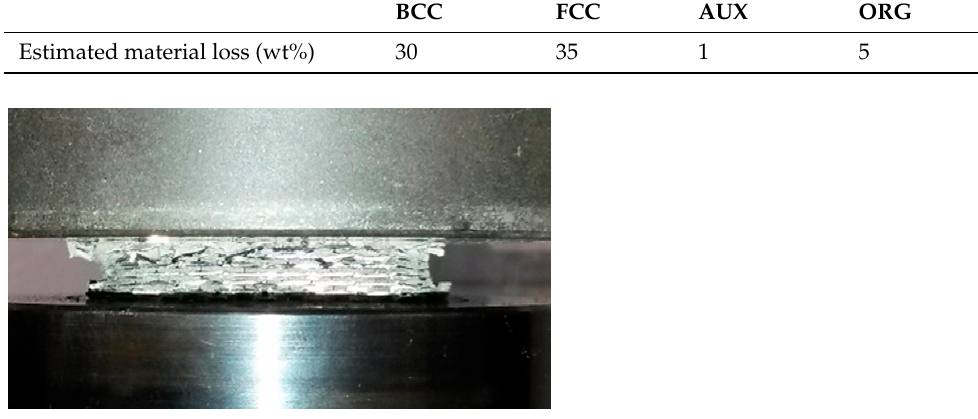
Figure 14 . Side view of crushed AUX lattice at its final failing point during compression, showing near perfectly uniform collapse properties.